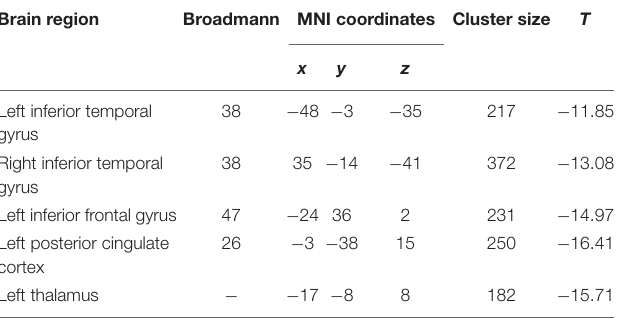
TABLE 3 | Gray matter volume differences between patient and control group at baseline.